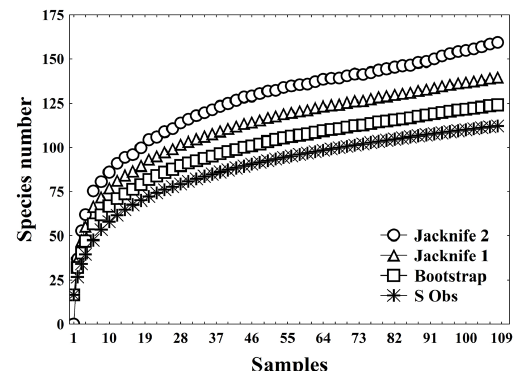
Figure 3. Nonparametric estimators for ciliate species richness in the Guaraná